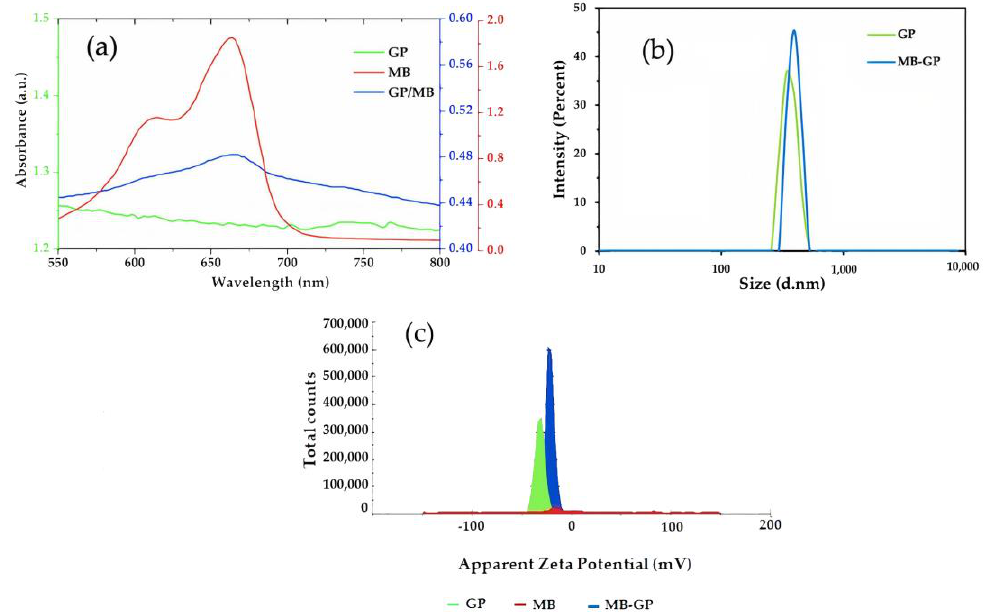
Figure 4. ( a ) UV spectra of MB ( red ) , GP ( green ) , and MB / GP nanohybrids ( blue ) in DI water . ( b ) Particle sizes of GP ( green ) and MB / GP nanohybrids ( blue ) measured by DLS . ( c ) Zeta potential of MB ( red ) , GP ( green ) , and MB / GP ( blue ) nanohybrids measured by ELS .